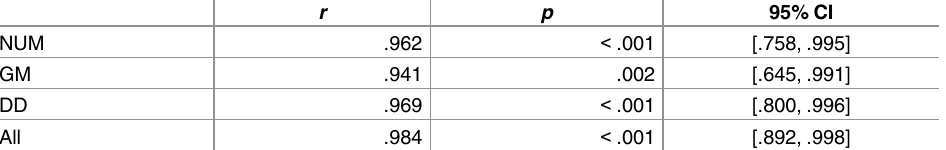
Table 8. Correlations between the official TIMSS 2007 achievement scores and the averagenumber of mastered attributes.